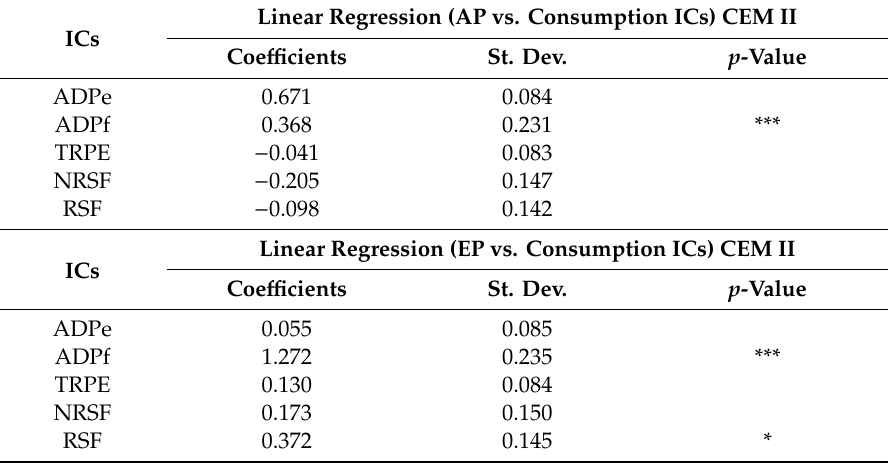
Table 20. AIC selection for GWP regression summary—CEM